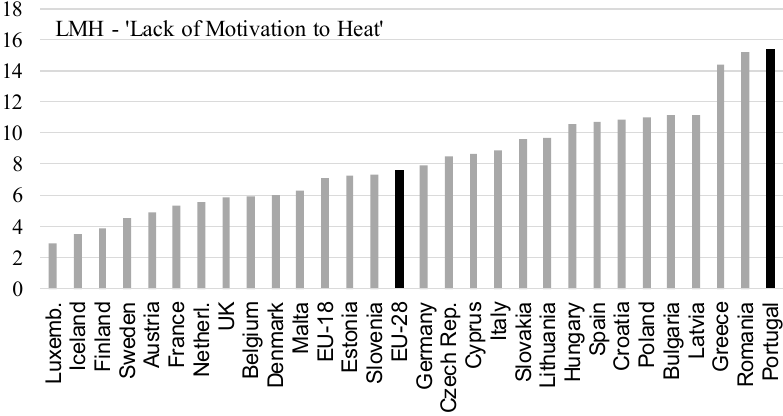
Figure 8. “Lack of motivation to heat” (LMH) across Europe (data source [69]).